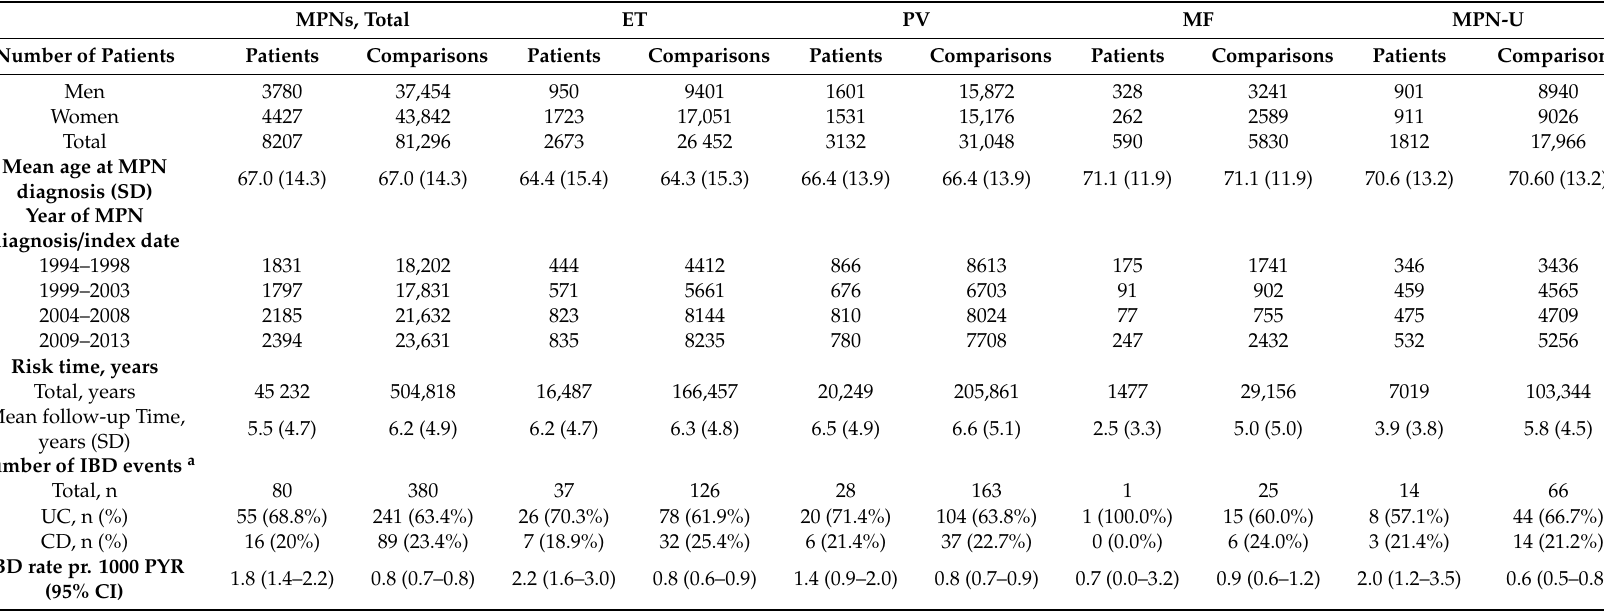
Table 1. Demographic characteristics of nationwide cohorts of patients 1994–2013 with myeloproliferative neoplasms (essential thrombocythemia, polycythemia vera, myelofibrosis, and unclassifiable myeloproliferative neoplasms) and sex- and age-matched comparisons without myeloproliferative neoplasms. MPNs, Total ET PV MF MPN-U Comparisons Patients